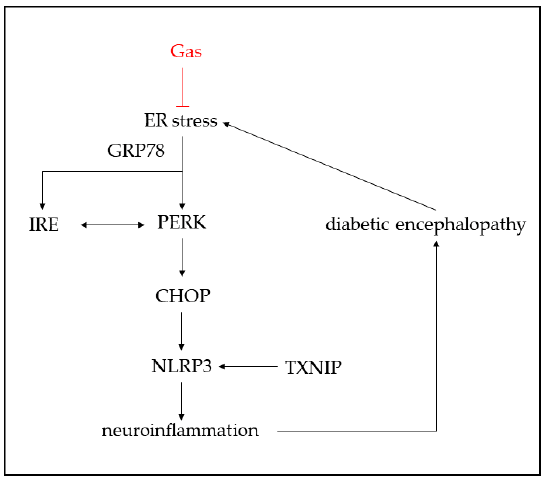
Figure 9. Schematic representation of Gas-mediated neuroprotective effect in db/db mice. Gas inhibited ER stress and NLRP3 inflammasome activation.